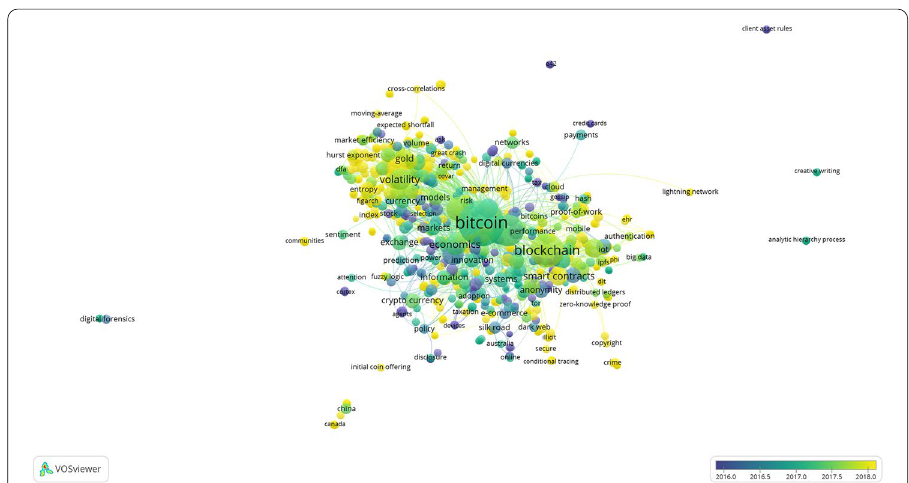
Fig. 10 Keywords on WoS. Source : Own compilation